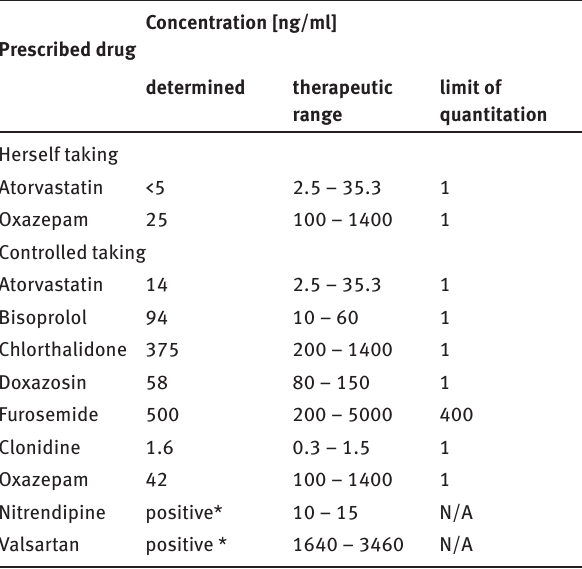
Table 1: Serum prescribed drugs concentrations, their therapeutic ranges and limits of quantitation of the methods used